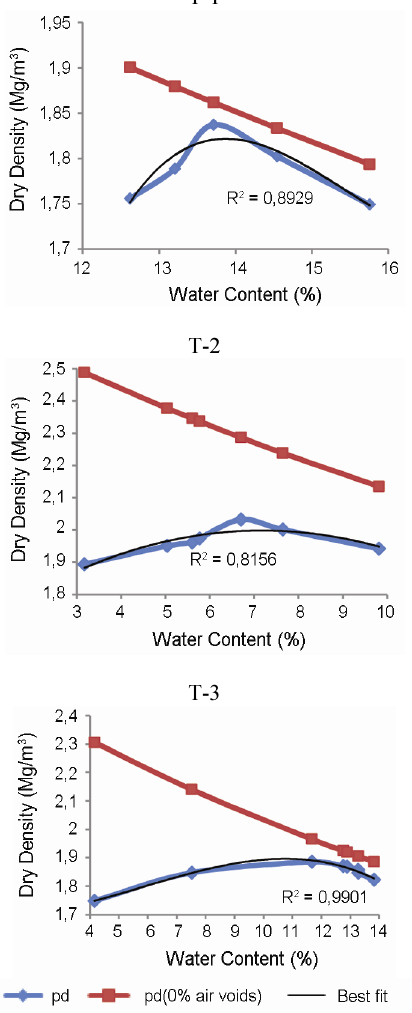
Fig. 4. Dry densities and corresponding water contents of T-1, T-2 and